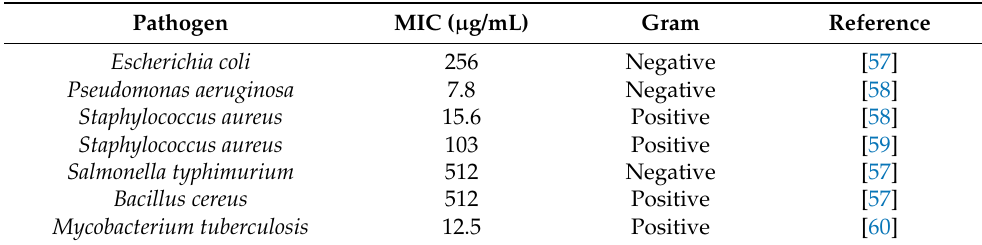
Table 2. Main MIC values for HQ.